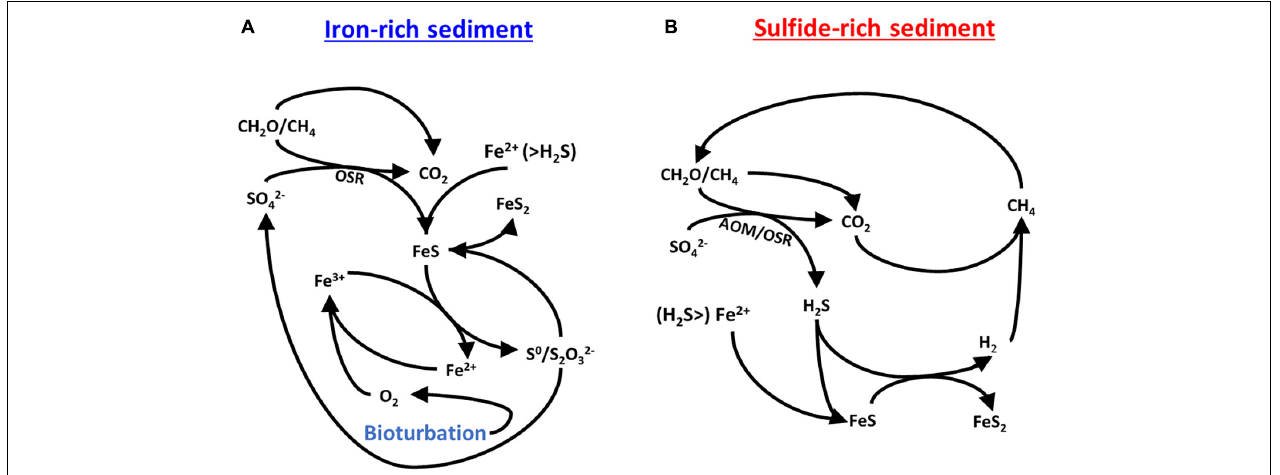
FIGURE 7 | A proposed mechanism for the possible carbon-sulfur-iron interplay in (A) the iron-rich sediment and (B) the sulfide-rich sediment. After Aller et al.